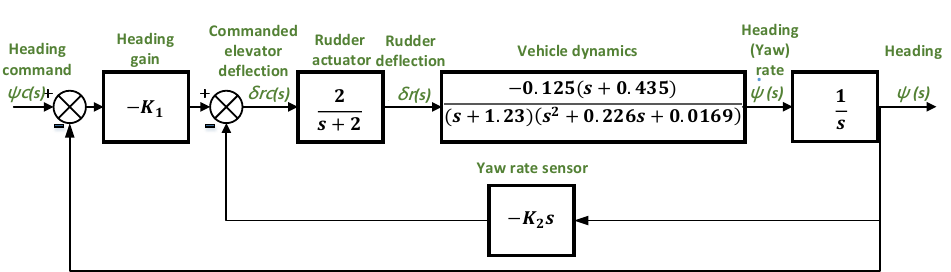
Figure 4. Open loop block diagram of the head control system.